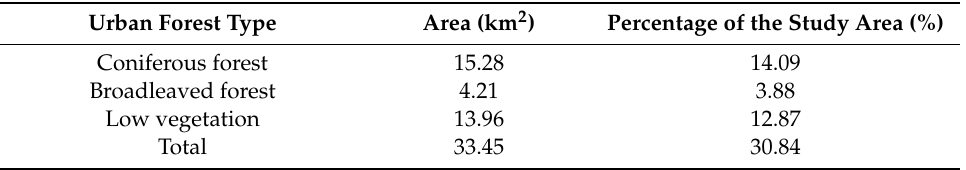
Table 3. Areas of urban forest types in the study